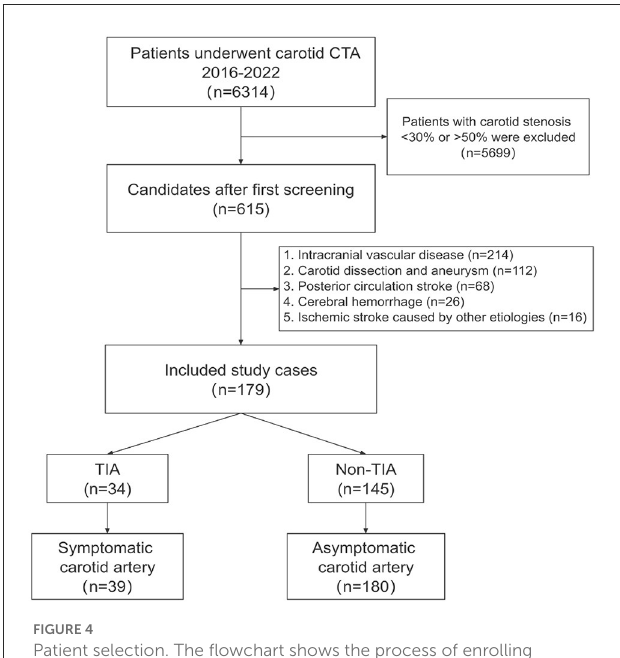
FIGURE4 Patient selection. The flowchart shows the process of enrolling patients in this study. The original population consisted of 6,314 subjects who had undergone carotid CTA studies, and we first screened the 615 subjects with mild carotid stenosis. According to the inclusion and exclusion criteria, we finally enrolled 179 subjects and included patients with TIA after CTA in the symptomatic group. CTA, computed tomography angiography; TIA, Transient ischemic attack.